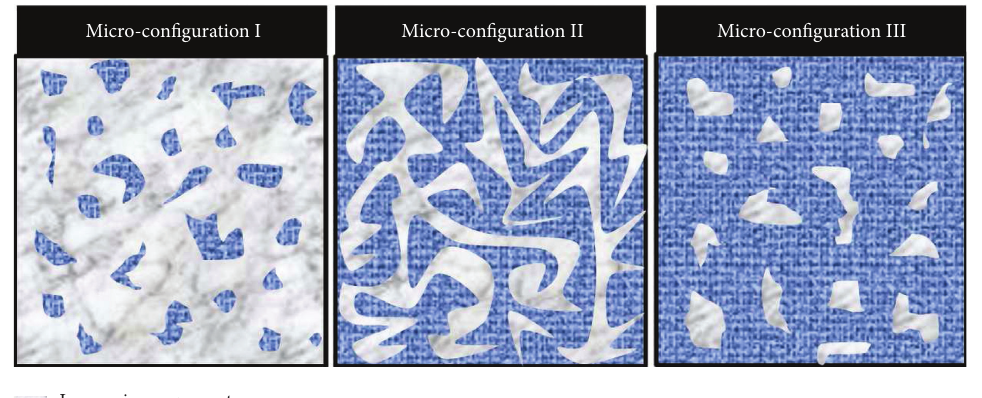
Figure 17: Three microscopic PCC